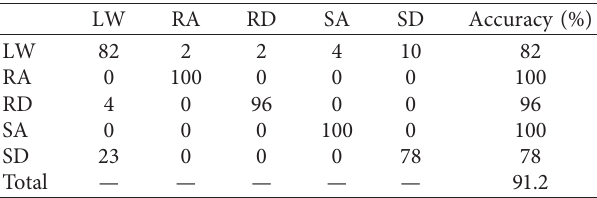
Table 4: The confusion matrix of LightGBM classifier in transi- tional